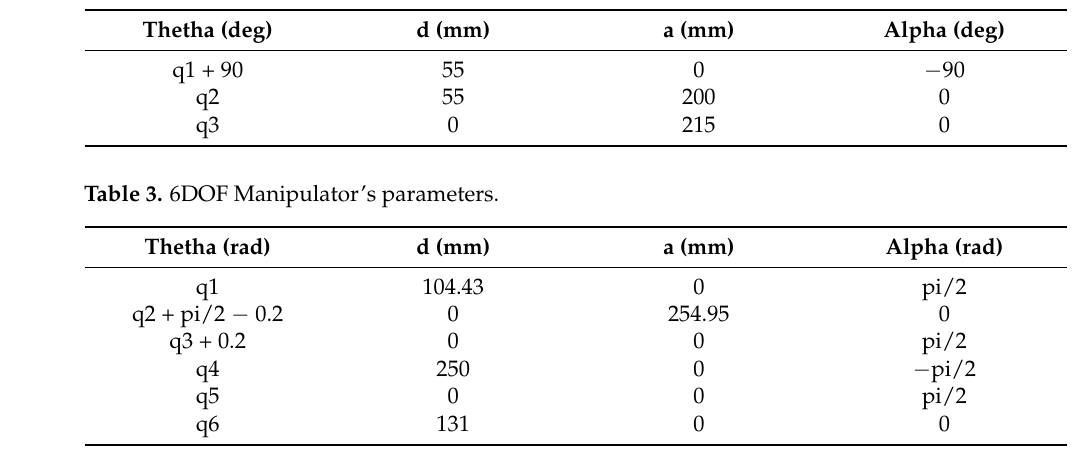
Table 2. One leg Denavit-Hartenberg’s parameters. 3DOF.